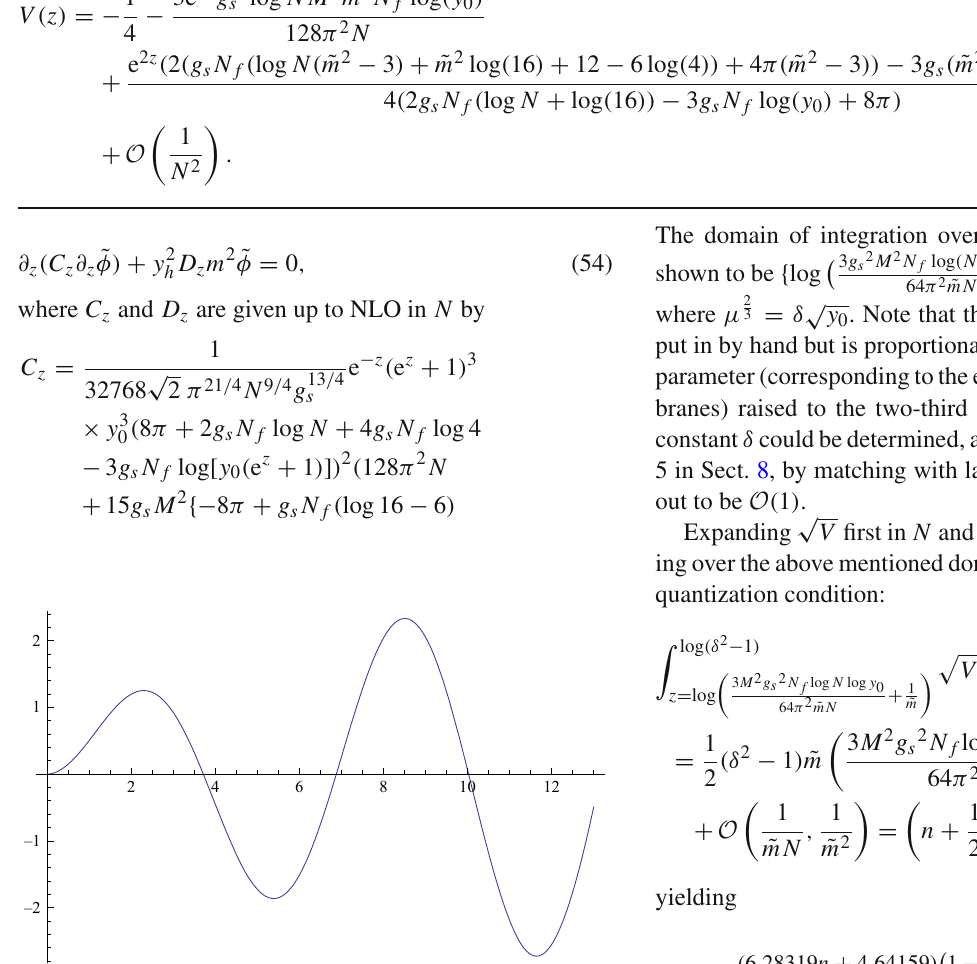
Fig. 1 0 ++∗ , ++∗∗ , ++∗∗∗ Masses obtained by graphical solution of the Neumann boundary condition in the r h = 0